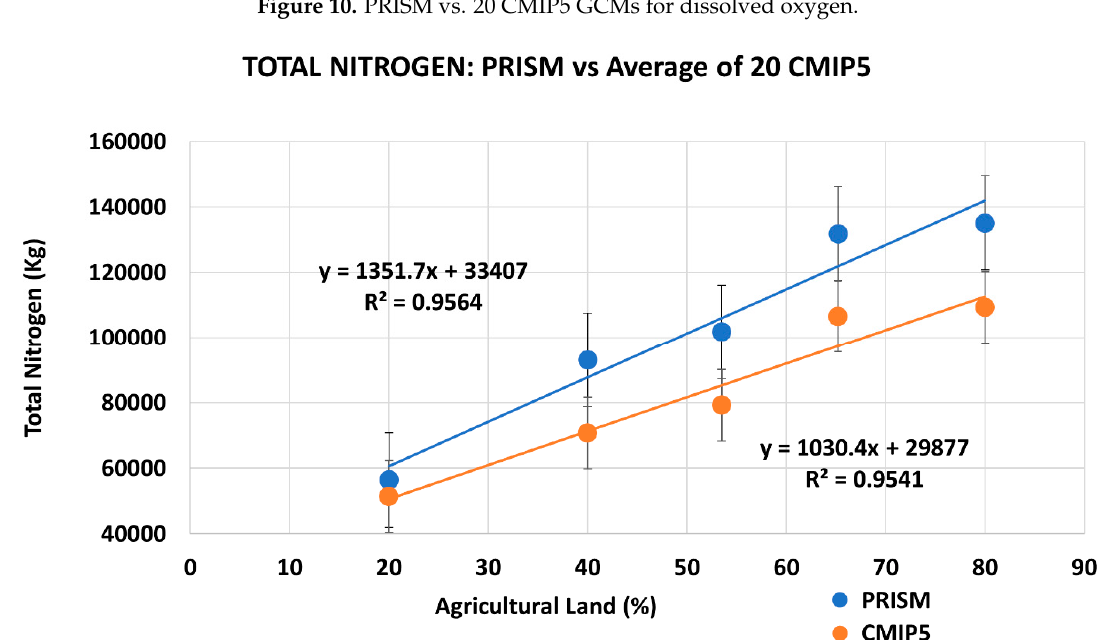
Figure 11. PRISM vs. 20 CMIP5 GCMs for total nitrogen.